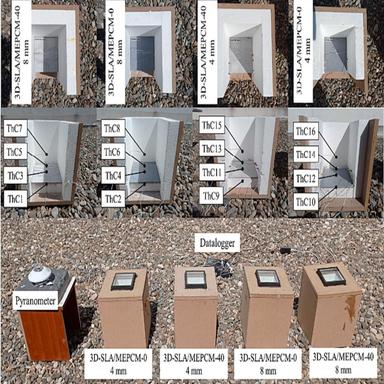
The configuration of the experiment and the placement of thermocouples within the test cabins.